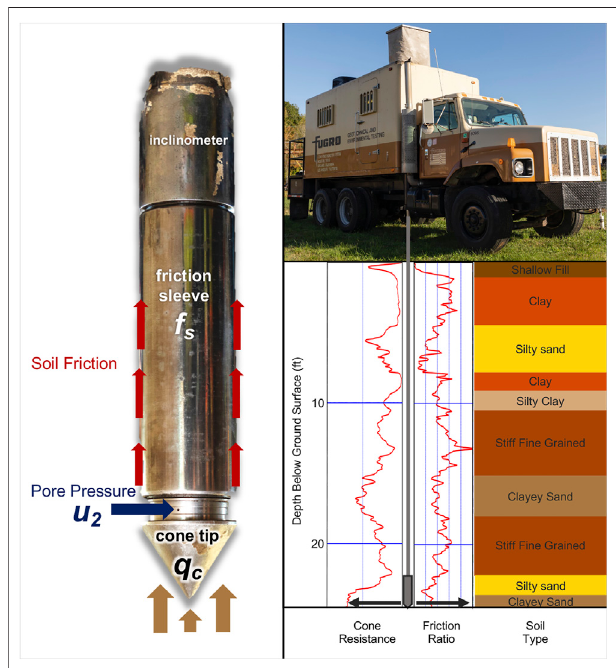
FIGURE 1 | Type 2 piezocone sensors (left) measure the axial force on the cone, the upward friction, and the inward pore pressure to determine soil behavior which is interpreted during piezocone advancement (right)